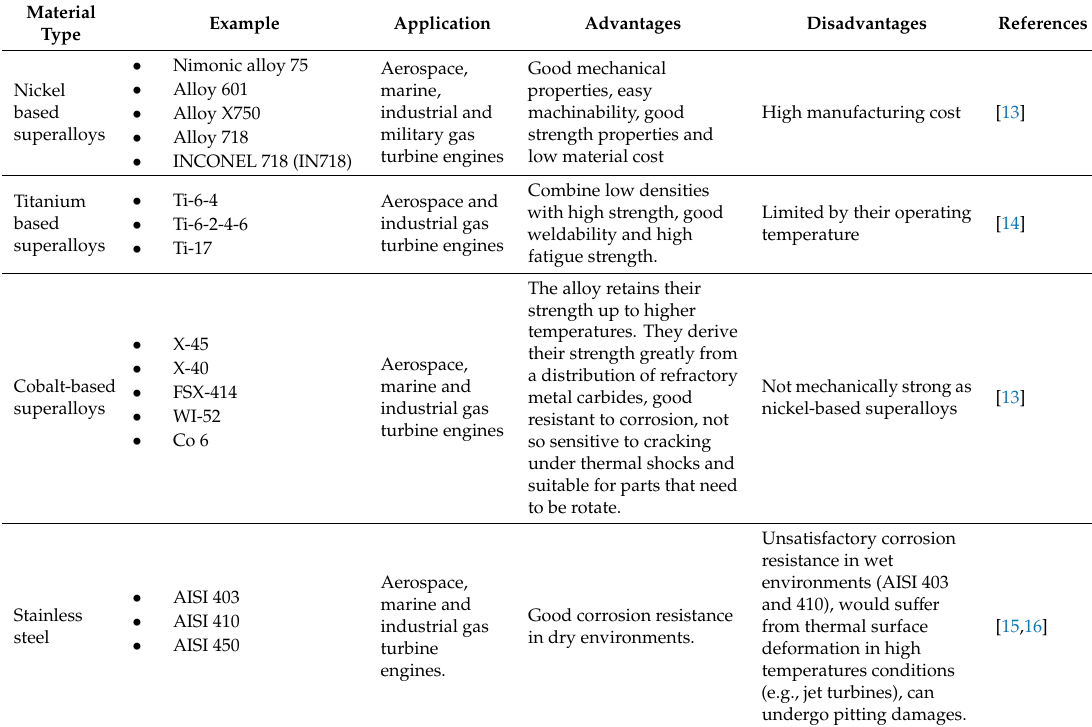
Table 1. Example of the materials used in fabricating compressors